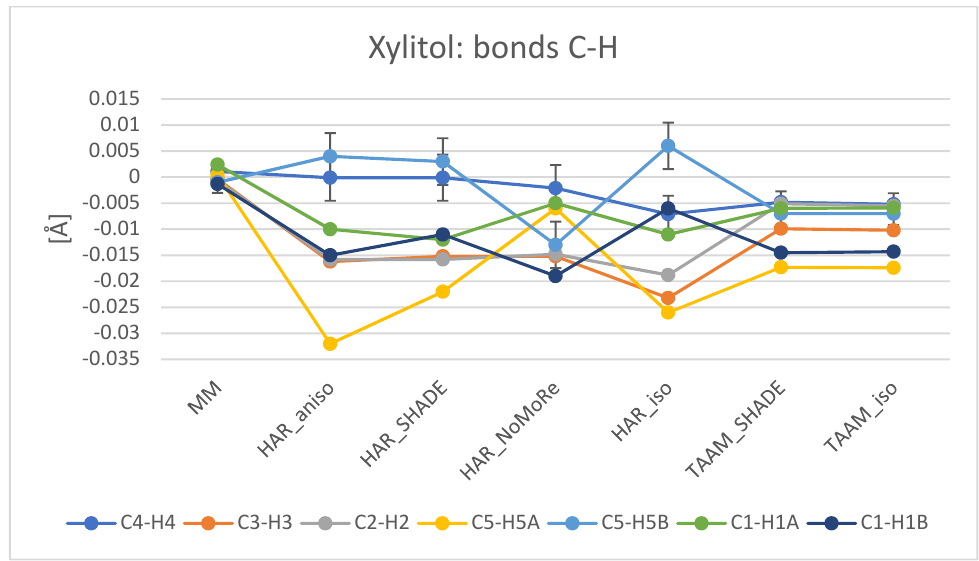
Figure 6. Comparison of C–H bonds for MM, HAR, and TAAM refinements of 2 . The values on the plot represent the difference between a given analysed model and the neutron data. Plotlines have no physical meaning, but aid in visual analysis. For clarity, +/ − 1 ESD intervals were added to selected bonds (C4–H4 and C5–H5B). Restraints were applied for MM and TAAM refinements. Plots for the comparison of C–H bonds in 1 and 3 are available in Supplementary Figure S11.